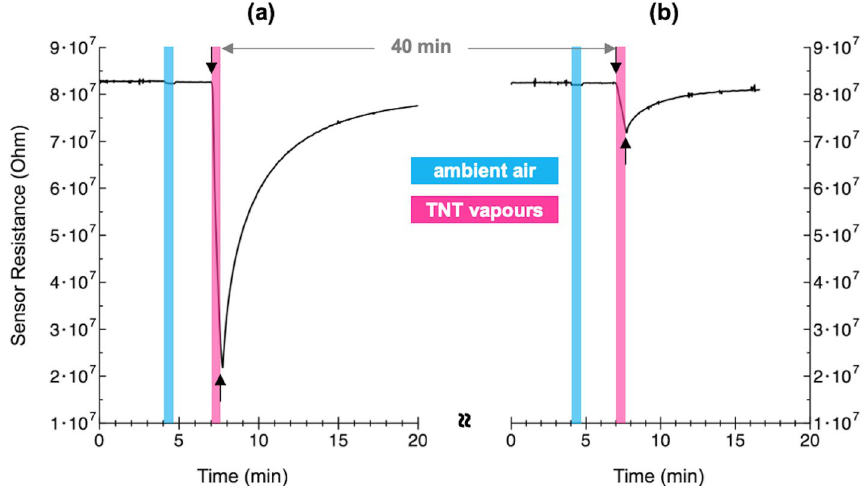
Fig. 5 Typical time response of the Ge NW network to ambient air (light blue areas) and TNT vapours (pink areas) for 45 s. Downward and upward arrows indicate the start and stop of exposure time of NW network device to TNT vapours. The measurements were performed after saturated ( a ) and unsaturated ( b ) vapour concentration was reached inside TNT